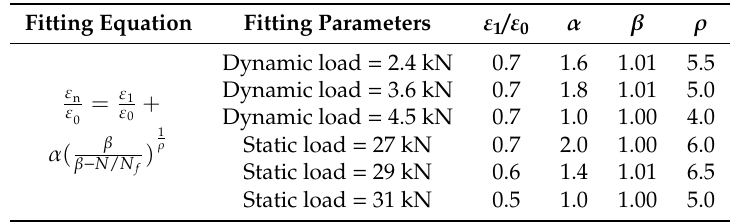
(b) ε n / ε 0 Figure 16. Evolution of strain characteristics for different dynamic stress: ( a ) strain increment, ( b ) ε n / ε 0 .